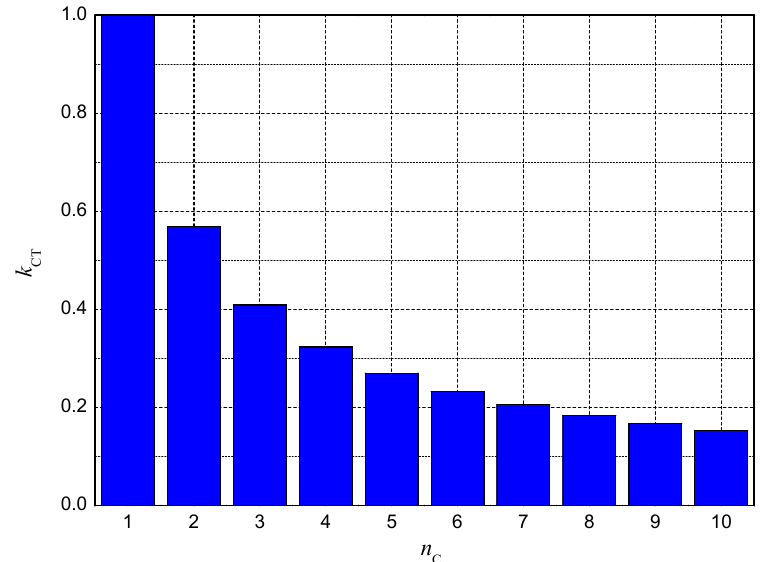
Figure 5. k CT values in light of number n c of the connected unshielded LV circuits.